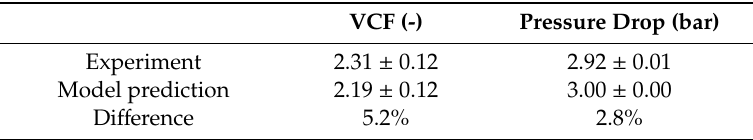
Figure 7. Axial profiles of concentration(blue), concentration at the membrane (orange), flux (black) and transmembrane pressure (red) for experiments and model prediction of BSA filtration. Table 3. Comparison of experimental and simulated process variables.